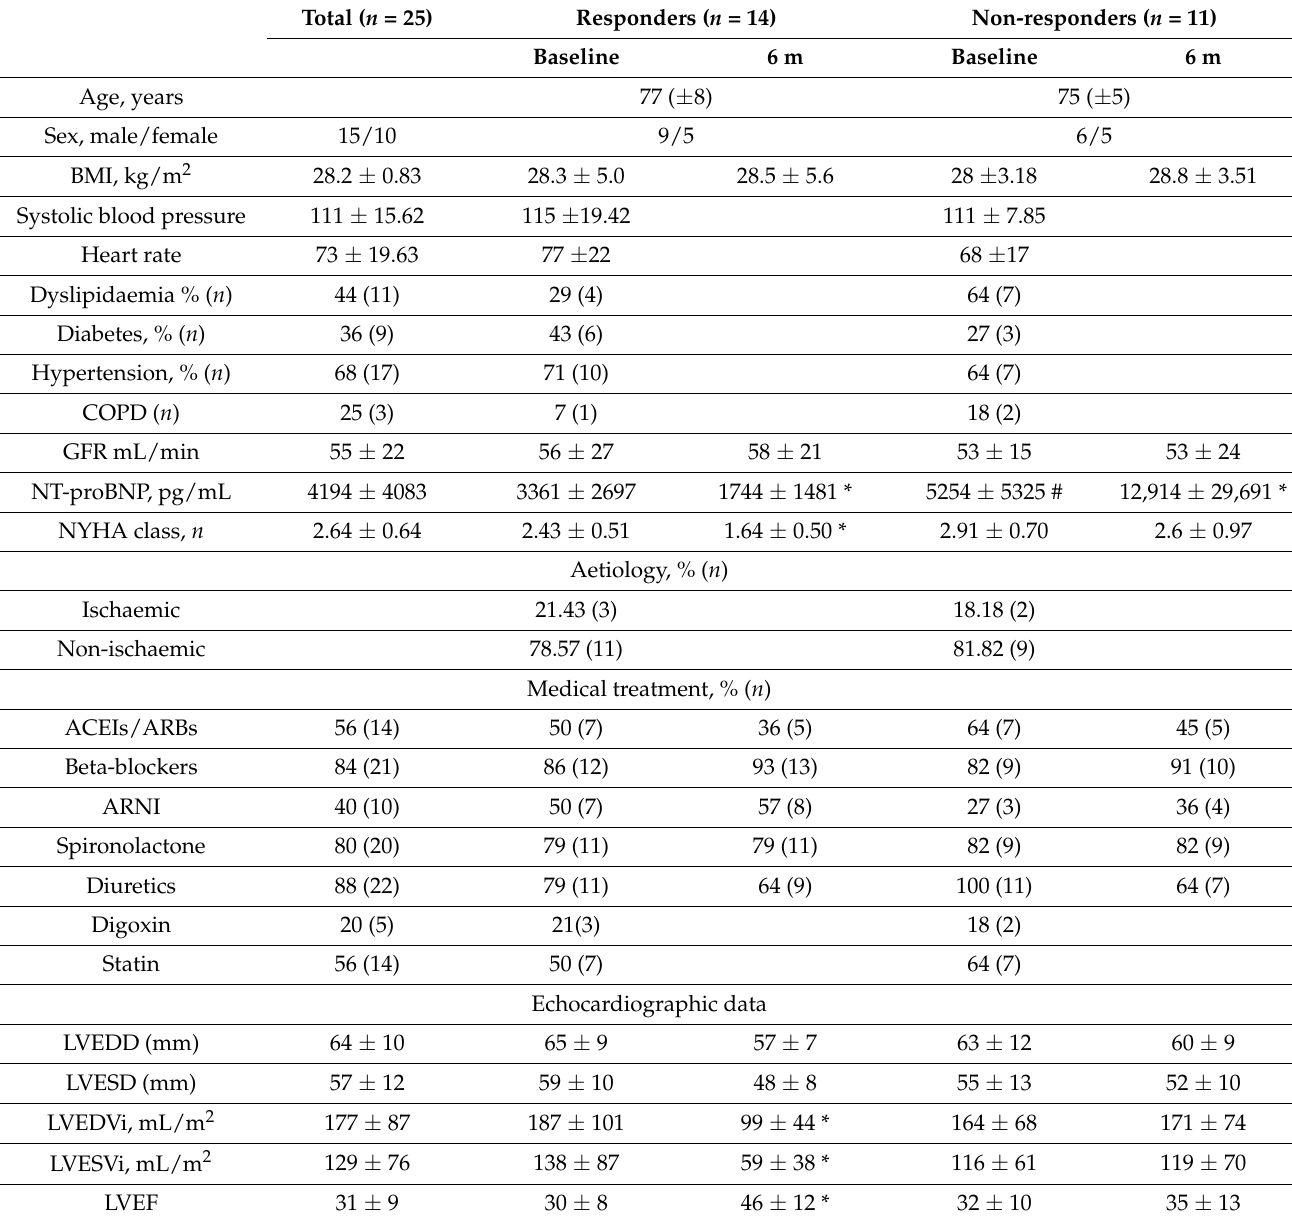
Table 1. Clinical parameters. Data are presented as mean + SD, % ( n ), or median and